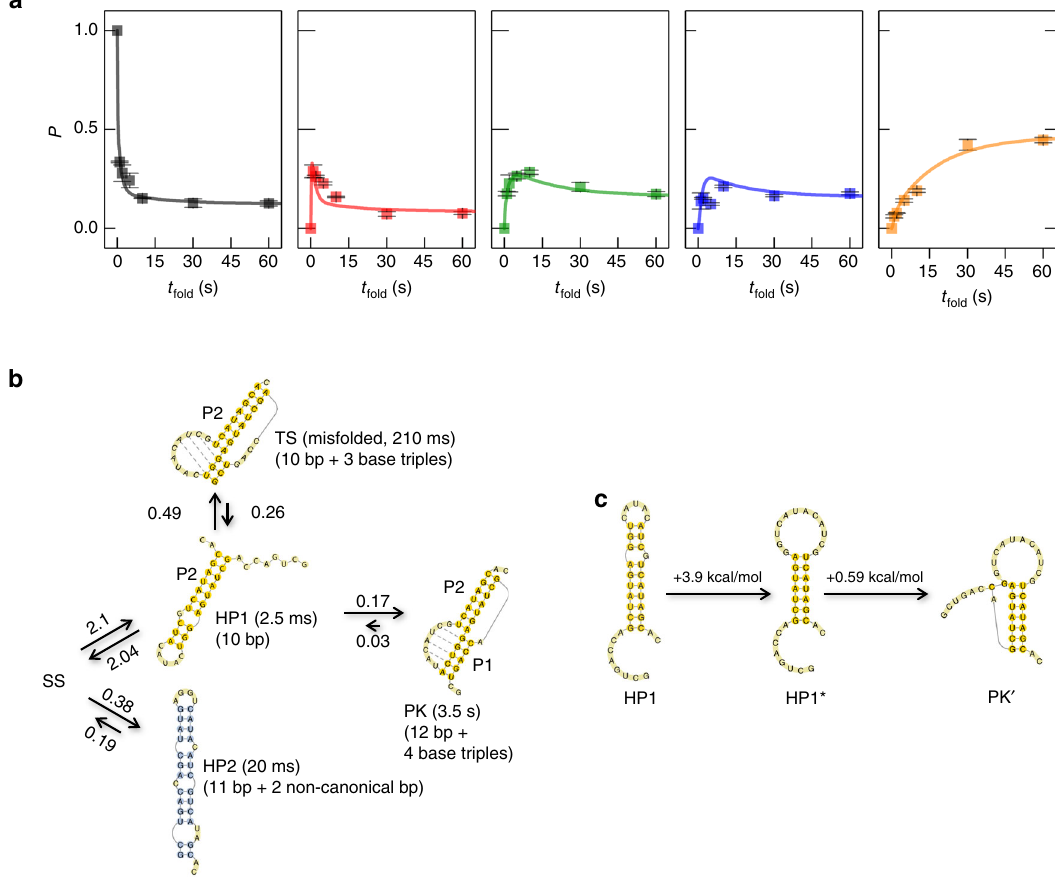
Fig. 4 Folding pathway of the T2 RNA pseudoknot. a The fractional population of the different states (from left to right, SS, HP1, HP2, TS, and PK, respectively) as a function of the folding time. The solid squares represent the experimental data. Error bars represent standard deviation of the mean ( n ≥ 3). We fi rst obtained the unfolding duration histogram at different folding times (Supplementary Fig. 3). Each histogram was then fi tted globally with a sum of four exponentials, and the normalized area of each component is the fractional population of the corresponding state (Methods). The curves in all plots of the panel were theoretically predicted based on the master equation approach. b The predicted pseudoknot folding pathway based on the analysis of the time-dependent population distribution and from the simulation. In the folding pathway of T2 PK, starting from the single-stranded (SS) state, the RNA can form two hairpin structures, HP1 and HP2. From HP2, the RNA can only go back to the SS state. Disruption of the non-native base pairs and loop – helix base triples in the misfolded TS state results in the HP1 structure. Therefore, the TS state can lead to the native PK structure via HP1 as the intermediate. Also shown in the fi gure are the fi tted rate constants (in s − 1 ) for the transitions between the states and the unfolding durations (shown in the parentheses) of each state under the +120 mV/ t fold = 10 s/ − 60 mV protocol. c Two “ uphill ” steps in the HP1 → PK folding process: disruption of the three non-native base pairs in the HP1 hairpin and the loop formation and the subsequent initiation of helix H2 formation in the native PK population kinetics for the fi ve states (Fig. 4a) yielded the estimated rate constants (Fig. 4b and Methods). SS is the initial state of the pathway for all the folding states observed. The RNA chain in the SS state quickly folds into the on-pathway intermediate HP1 and the off-pathway intermediate HP2. The